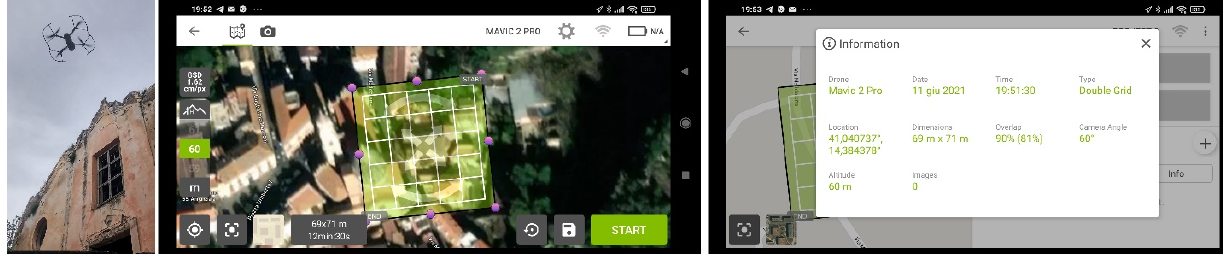
Figure 7. Drone photogrammetric survey activity. Flight